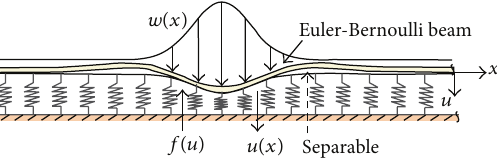
Figure 2: An infinite beam on a nonlinear elastic foundation: a nonlinear spring